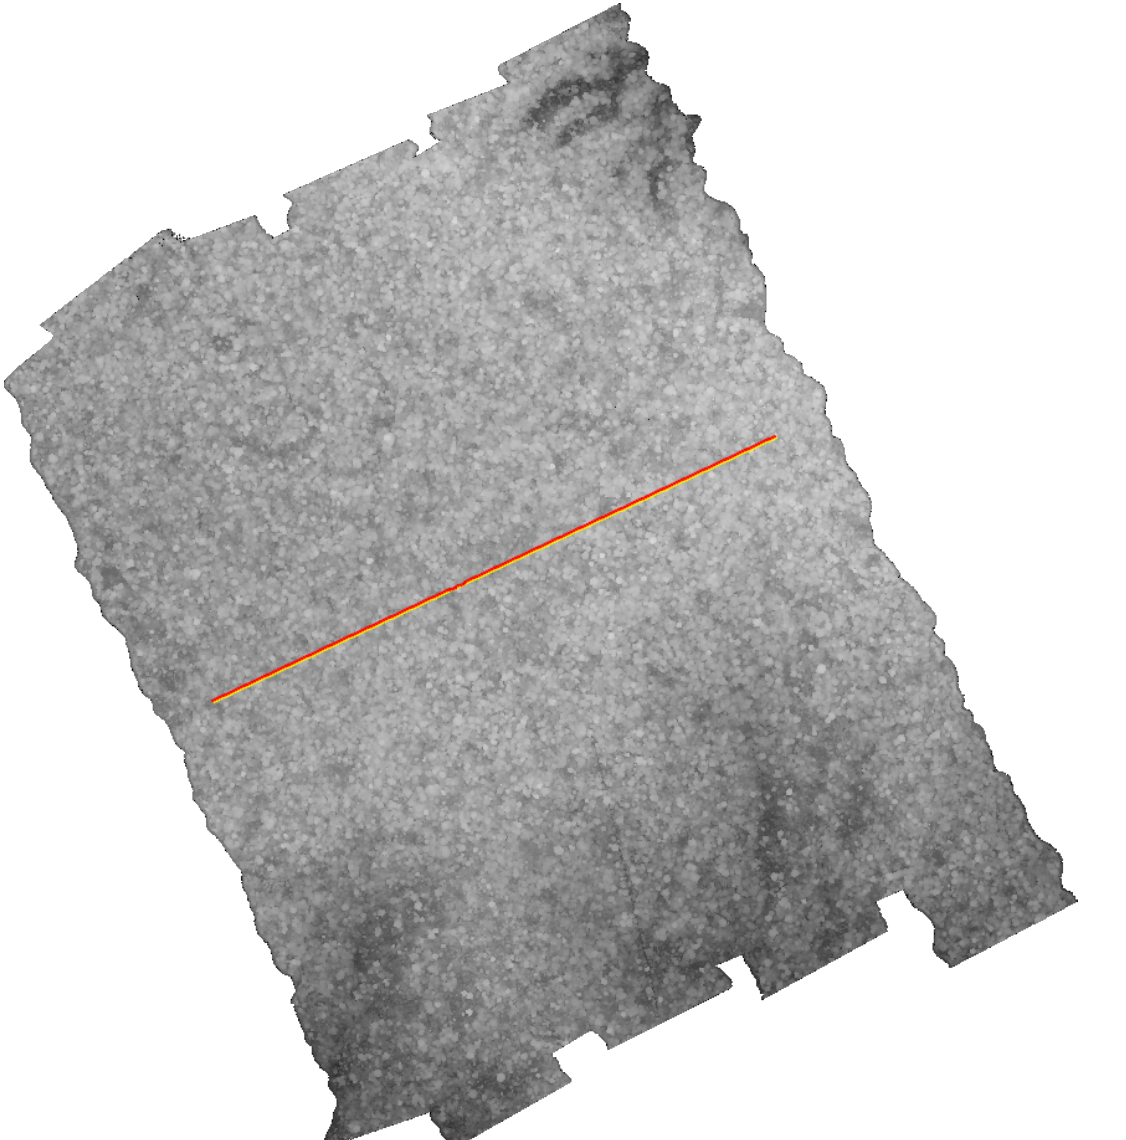
Figure 18. Trajectory in yellow on filtered surface, square bin, experiment. Corresponding estimated positions are drawn in